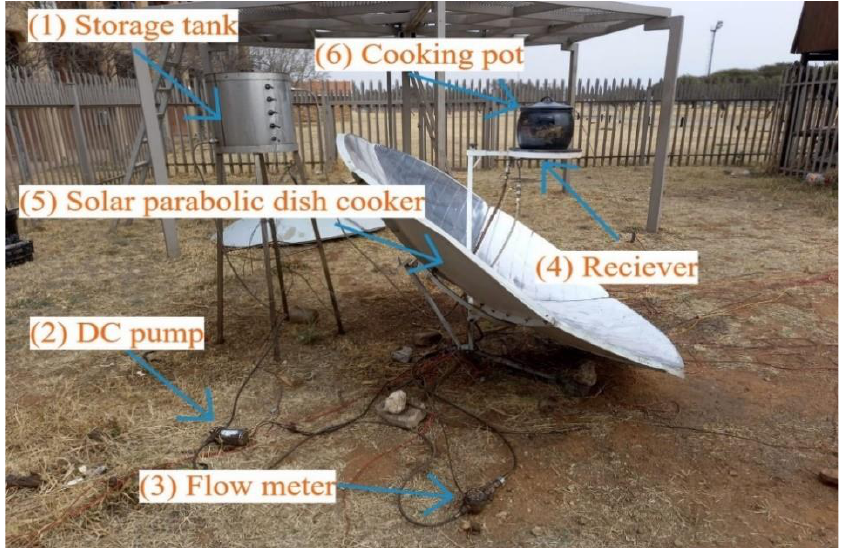
Figure 1. An outdoor experimental setup of an SK-14 parabolic dish cooker combined with a TES system. The experimental components that were utilized are ( 1 ) a storage tank, ( 2 ) DC pump, ( 3 ) flow meter, ( 4 ) receiver, ( 5 ) solar parabolic dish cooker, and ( 6 ) a cooking pot. A 30 L stainless steel storage tank (1) with a diameter of around 0.03 m was filled up with sunflower oil. It was insulated with 0.005 m of rock wool, and it was a cylindrical structure. Sunflower oil was also used as the heat transfer fluid (HTF). Five K-type were attached along the height of the storage to measure the axial temperature distribution (TA-TE) as shown in Figure 2b. Circulation of the heat transfer fluid was induced by a DC pump (2) which was connected to the storage tank via a positive displacement flowmeter (3) with an accuracy of ± 1%. The HTF was heated in a receiver (4) which was connected to the top of the storage to charge it after absorbing concentrated solar thermal energy from the parabolic dish solar cooker (5). A copper spiral coil embedded underneath a black-painted circular plate constituted the receiver as shown in Figure 2a. The receiver placed at the focal point of the parabolic dish absorbed concentrated solar thermal radiation from the parabolic dish. A Kipp & Zonen CHP1 Pyrheliometer measured the direct solar radiation while placed on a Kipp & Zonen SOLYS 2 Solar tracker. Simultaneous heating of the load in a black cooking pot (6), and heating of circulating sunflower in the coil was made possible by absorbing the concentrated solar radiation. Different test loads of both sunflower oil and water were poured into the pot and used in the experiments. During the discharging period, the solar parabolic dish cooker was defocused, and the DC pump was configured to extract the heated fluid from the top of the storage tank. The hot